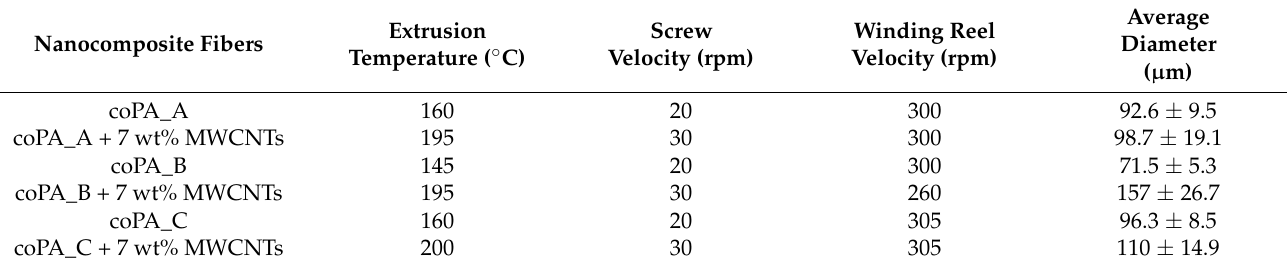
Figure 1. The equipment used to produce nanocomposite fibers: ( a ) extruder with a forming fiber; ( b ) fibers on a winding reel; ( c ) produced nanocomposite fibers; ( d ) an example fiber with measured diameters. Table 2. The melt-spinning conditions to produce nanocomposite